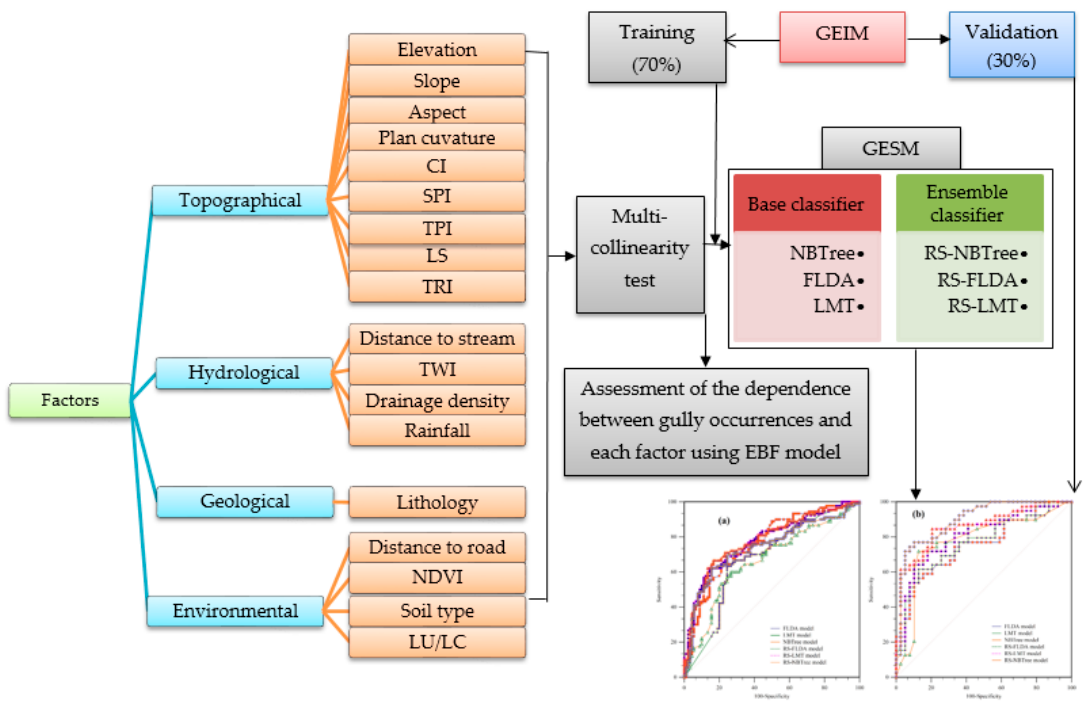
Figure 4. Research flowchart of the present study.